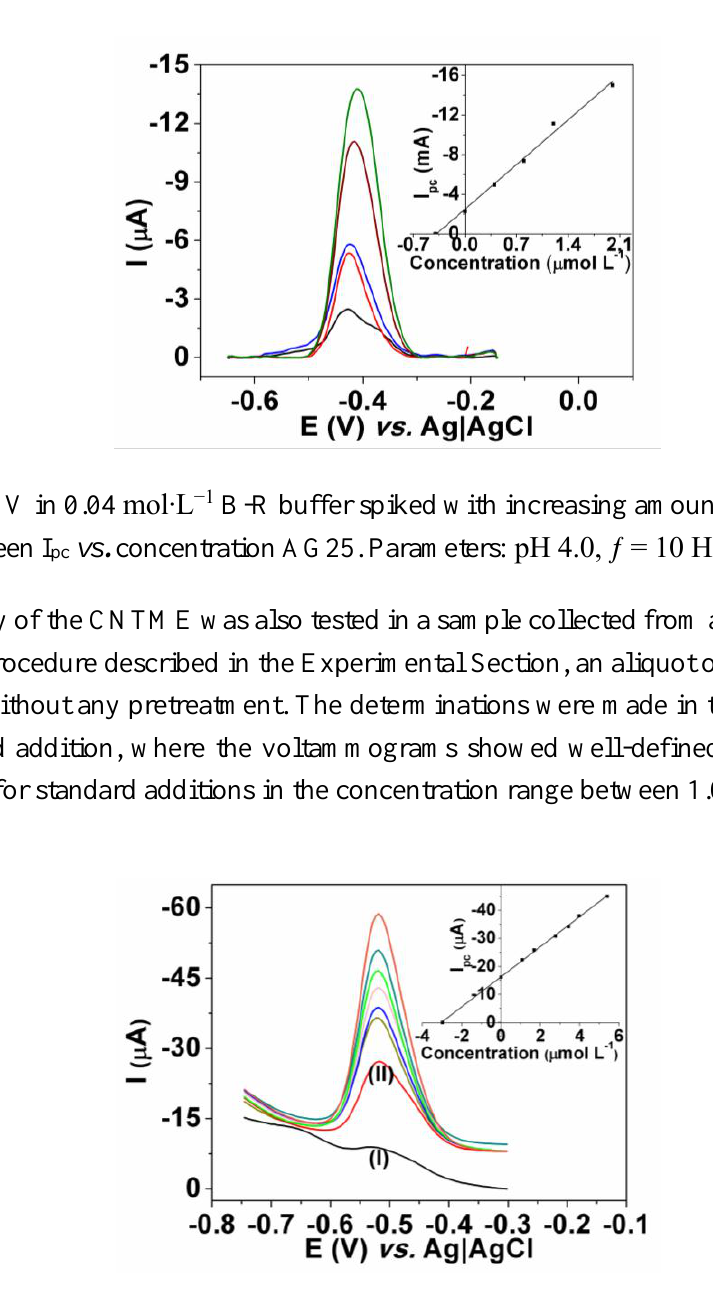
Figure 9. SWV for the CNTME in 0.04 mol·L −1 B-R buffer (pH 4.0) (I), plus 40 μL of added sample (II) and successive standard additions of AG25 between 1.07 and 5.40 μmol·L −1 .